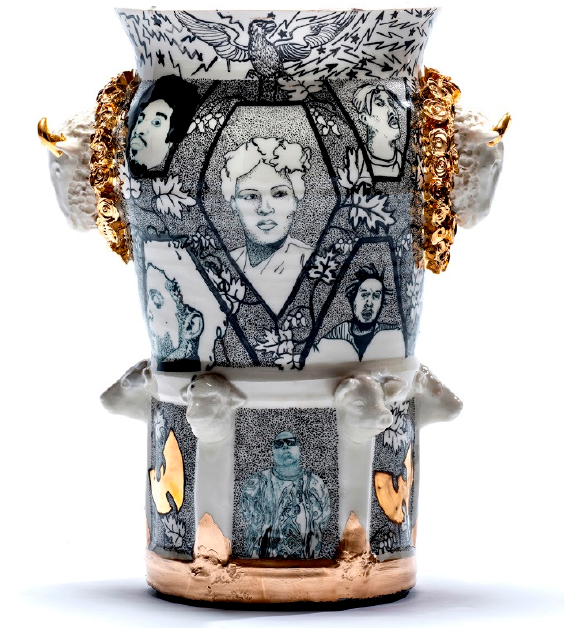
Figure 4. Method Man and Jimi Hendrix, 2018 , Earthenware and china paint, 13 × 13 × 26 in. Image by KeneK Photography, courtesy of Wexler Gallery.